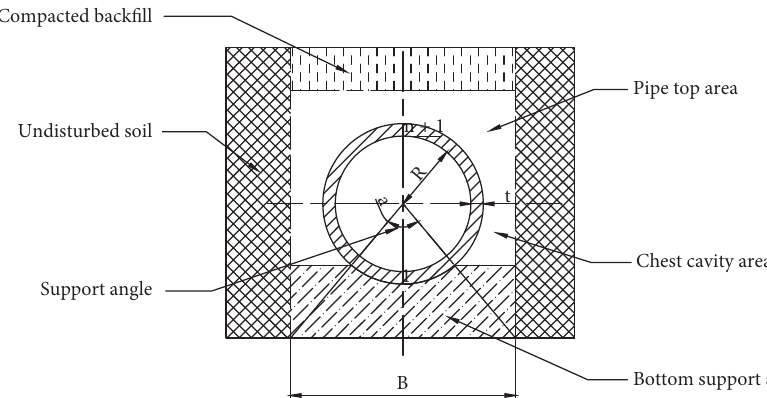
Figure 5: Calculation model of a buried